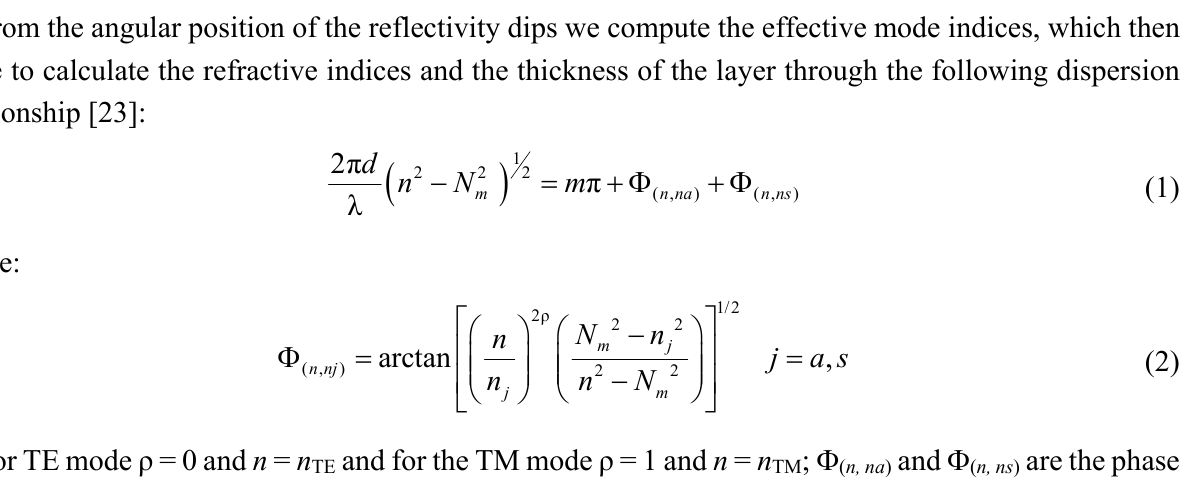
-350 thin film: ( a ) transverse electric (TE) and 2